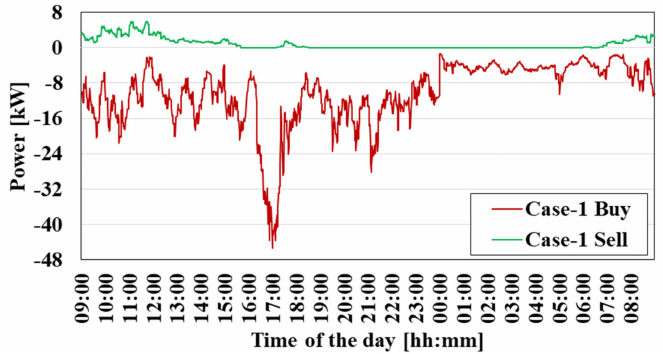
Figure 17. Total power exchange in dwellings with residential